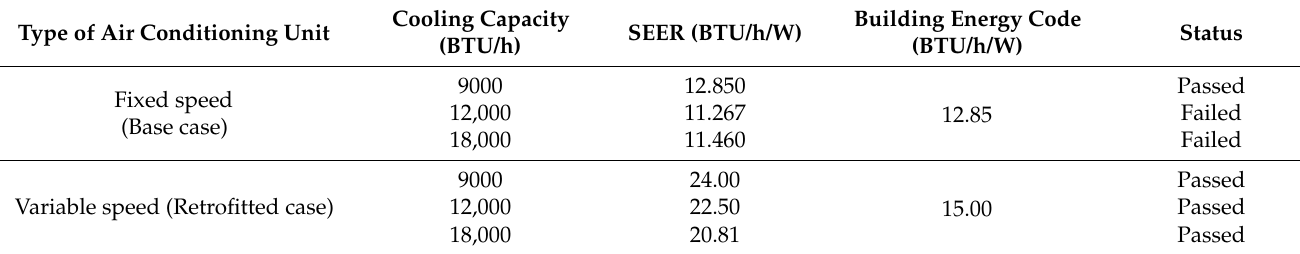
Table 15. Evaluated results of the air conditioning units in comparison with the building energy